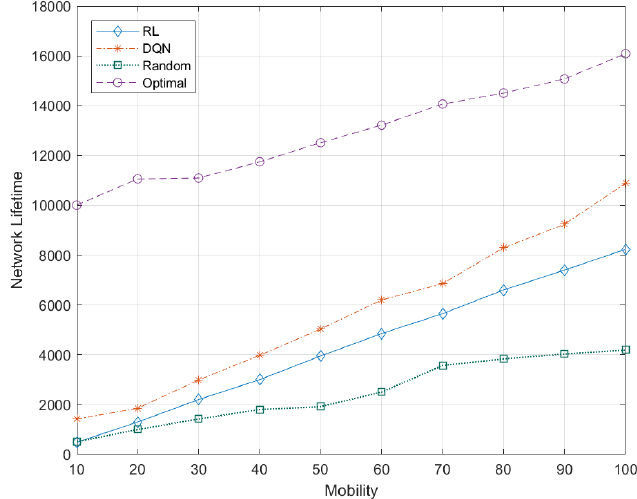
Figure 14. Network lifetime increases with respect to mobility rate. DQN achieves higher values as compared to RL and random approaches. Higher network lifetime improves QoS and network stability.